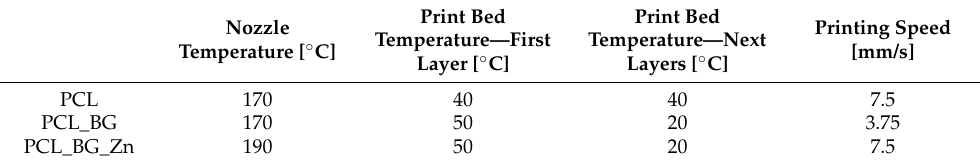
Table 2. Printing process parameters for PCL, PCL_BG, and PCL_BG_Zn filaments. Print Bed Nozzle Temperature [ ◦ C]